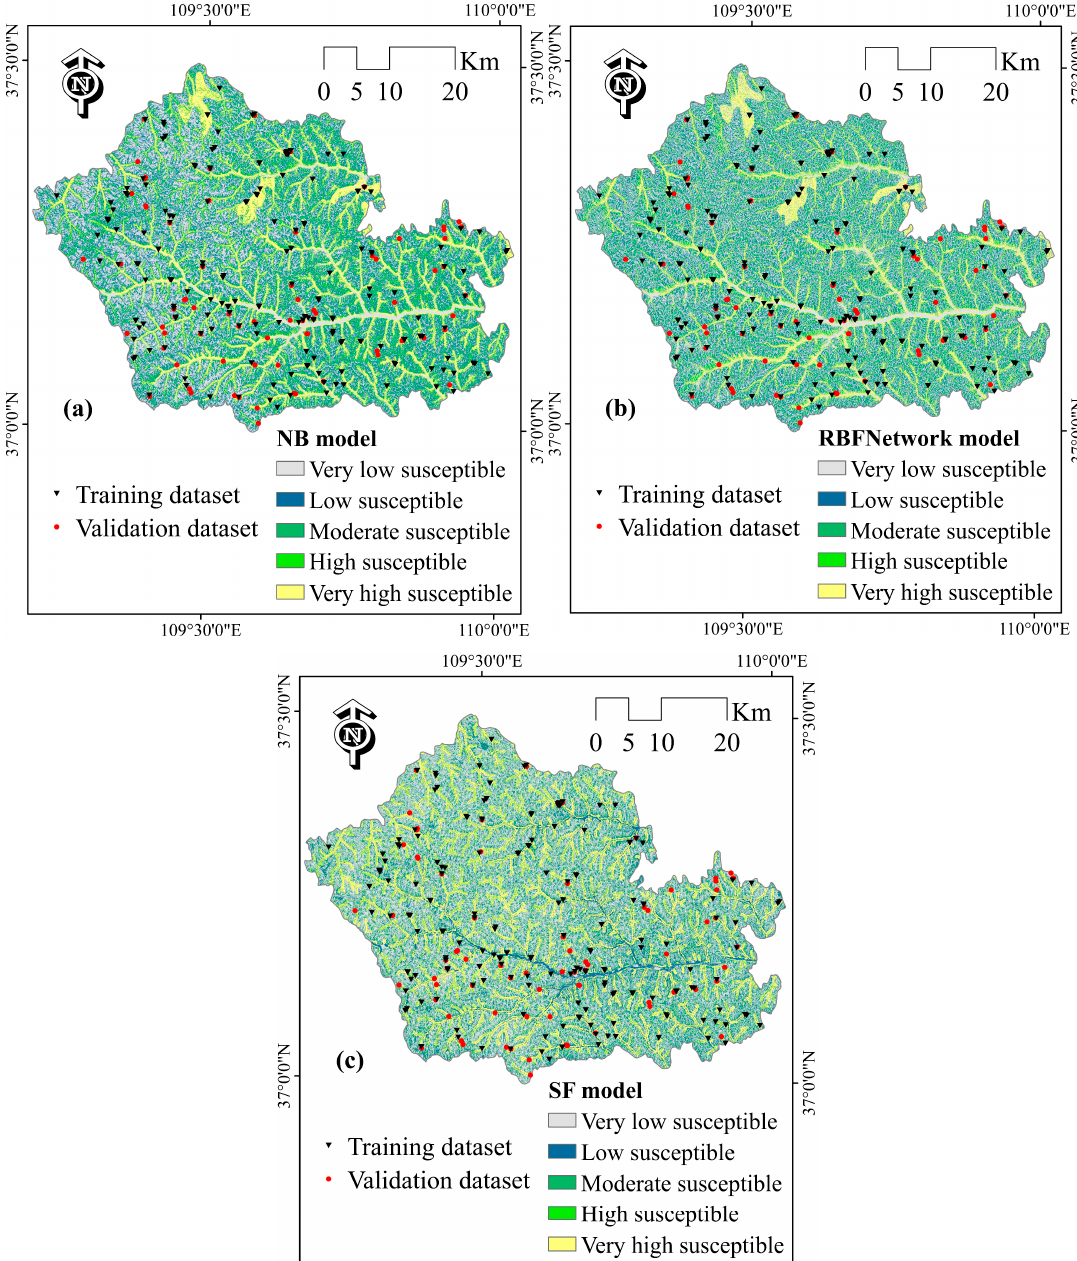
Figure 5. Landslide susceptibility maps: ( a ) naïve Bayesian (NB) model; ( b ) RBFNetwork model; ( c ) SysFor (SF) model.